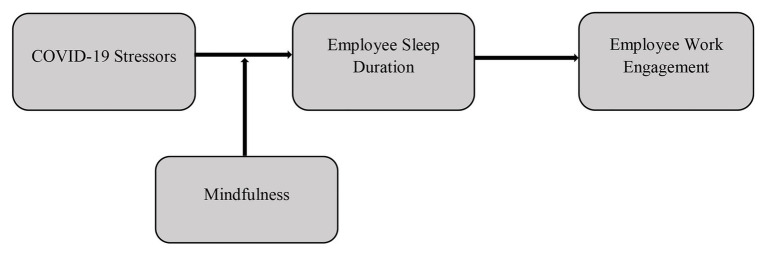
Conceptual model.